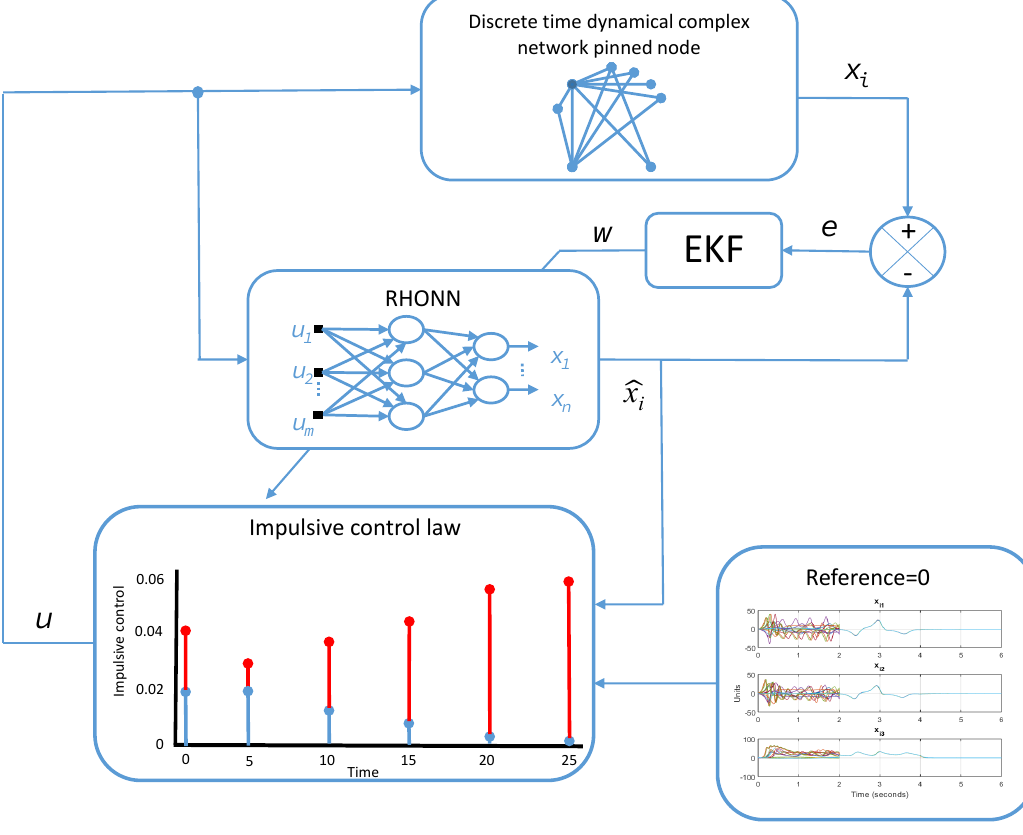
Figure 3. Control scheme implemented in